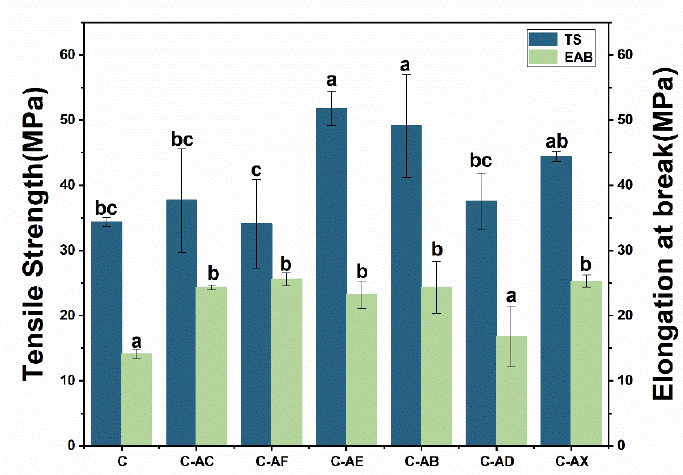
Figure 7. Mechanical properties of collagen-based film. TS = tensile strength, EAB = elongation at break. C (collagen film); C-AC (collagen with none-modified APL film); C-AF (collagen with C. echinulate FR3-modified APL film); C-AE (collagen with G. lucidum EN2-modified APL film); C-AB (collagen with P. ostreatus BP3-modified APL film); C-AD (collagen with S. commune DS1-modified APL film); C-AX (collagen with Xylariaceae sp. XY-modified APL film). For the comparison between different biological modifications, different lowercase letters represent significant differences ( p < 0.05).